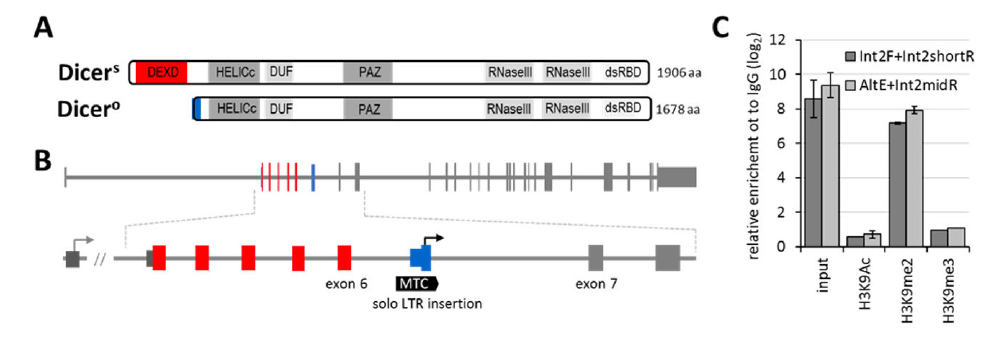
Figure 1. ( A ) Schemes of murine oocyte-specific truncated Dicer protein (Dicer O ) and full-length Dicer (Dicer S , S for somatic). ( B ) Genomic organization of the Dicer1 gene indicating the position of the alternative promoter and the first exon encoding Dicer O . The alternative promoter and the first exon reside in MTC LTR insertion between exons 6 and 7, and its structure and evolutionary history have been described elsewhere [15]. ( C ) Native chromatin immunoprecipitation analysis of H3K9 modifications in the MTC Dicer O promoter region in NIH 3T3 cells. Relative enrichment analyzed by two primer pairs is depicted as log 2 -fold enrichment calculated to